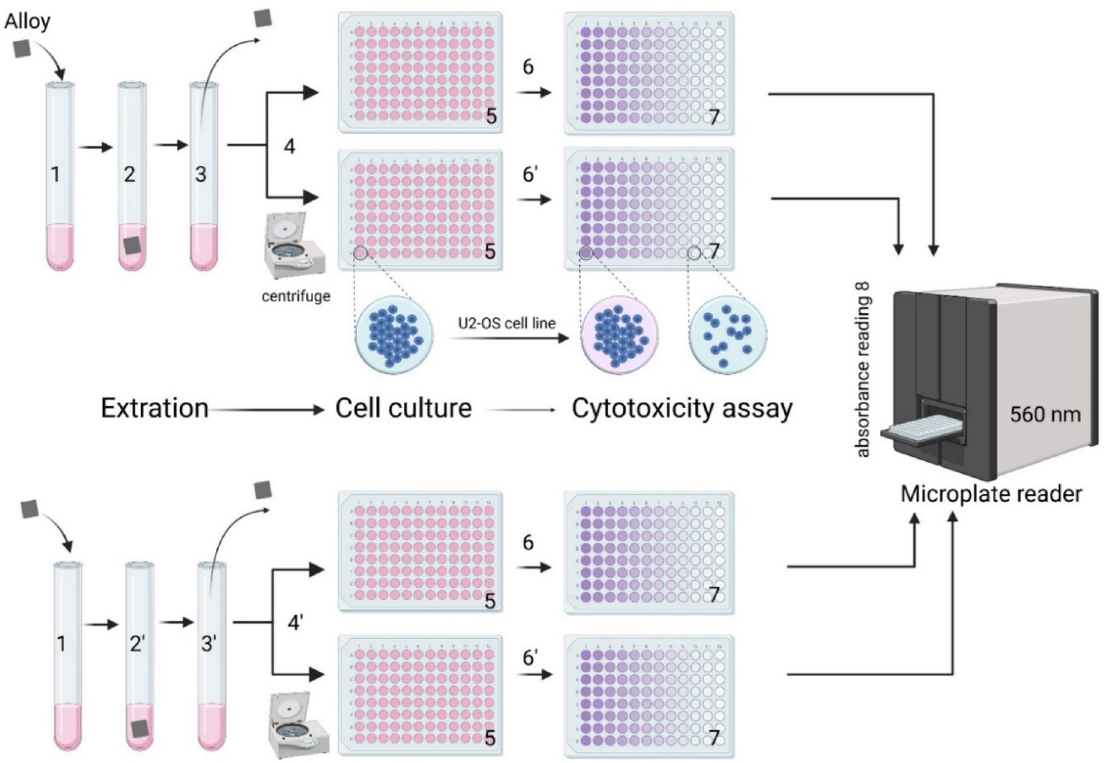
Figure 1. Schematic ilustration of cytotoxicity test according with ISO